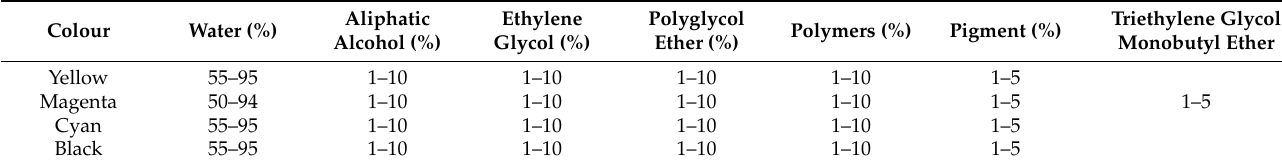
Table 2. Printing inks